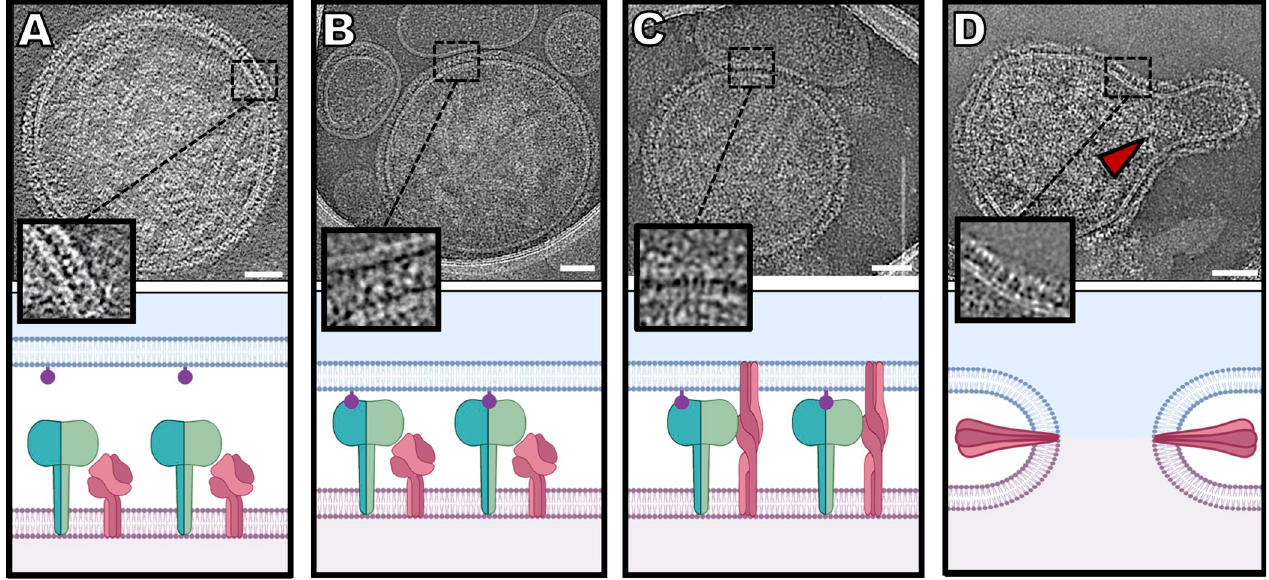
Fig 6. Sequence of events in HPIV3 entry, corresponding to cryo-electron microscopy imaging. ( A ) HN (green) and F (dark pink) can be found densely packed on the viral surface (light pink) (Image from Fig 1A ). ( B ) Sialic acid (purple) binding to HN occurs in the presence of a host target membrane (blue) (Image from Fig 3B ). ( C ) Upon triggering of F by HN, F undergoes a large conformational change from a pre-fusion globular structure to an extended structure that crosses both membranes (Image from Fig 4B ). ( D ) After this intermediate state, F folds back onto itself, pulling both membranes towards each other, creating a pore in a process that ultimately results in a merged membrane. Scale bars: ( A-D ) 50 nm.